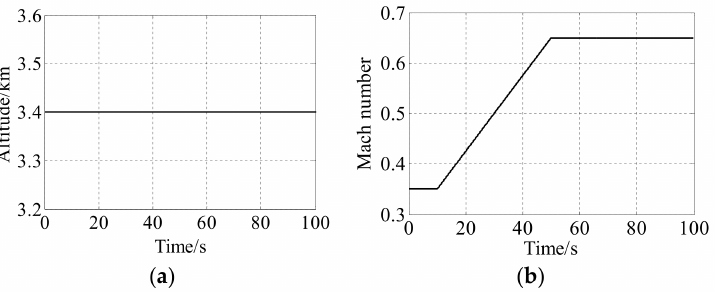
Figure 21. Altitude and Mach number test conditions. ( a ) Altitude test conditions; ( b ) Mach number test conditions.